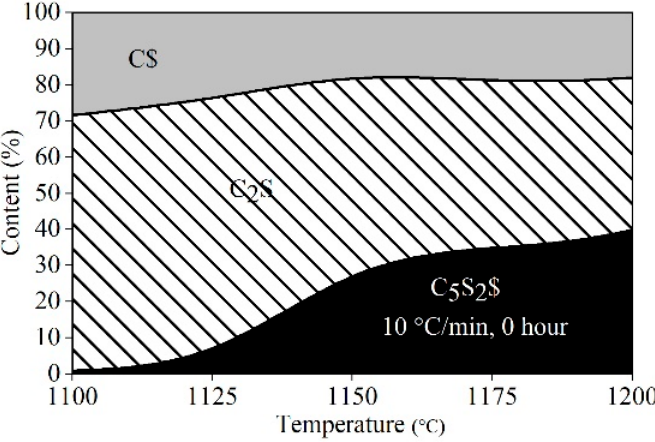
Figure 7. Area plot of the phase composition for the sintering of the raw mixture of beta-C 2 S and CaSO 4 ∙ 2H 2 O at temperatures from 1100 °C to 1200 °C without holding time.